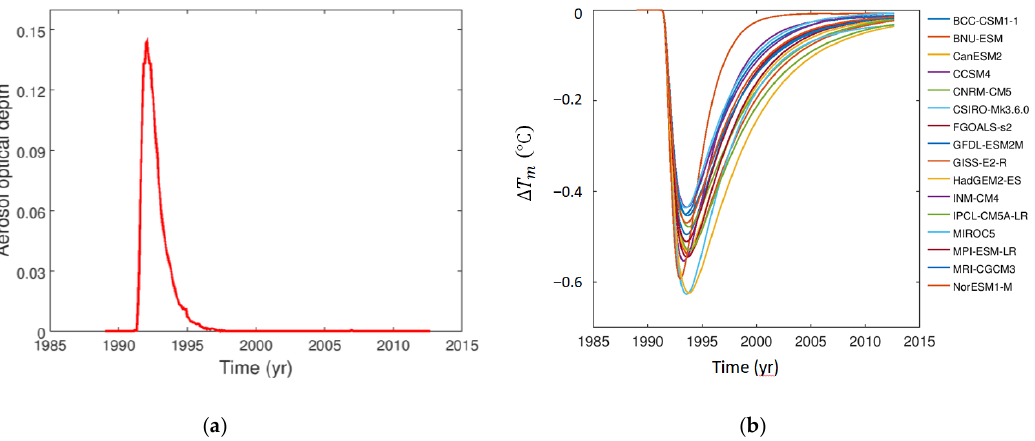
Figure 1. Global mean total optical depth 𝜏 𝐴 at 550 nm for the case of the Mount Pinatubo 1991 eruption ( a ) and the corresponding global mean surface temperature anomalies ∆𝑇 (℃) derived from running various energy balance models (EBMs) with parameters listed in Table 1 ( b ).